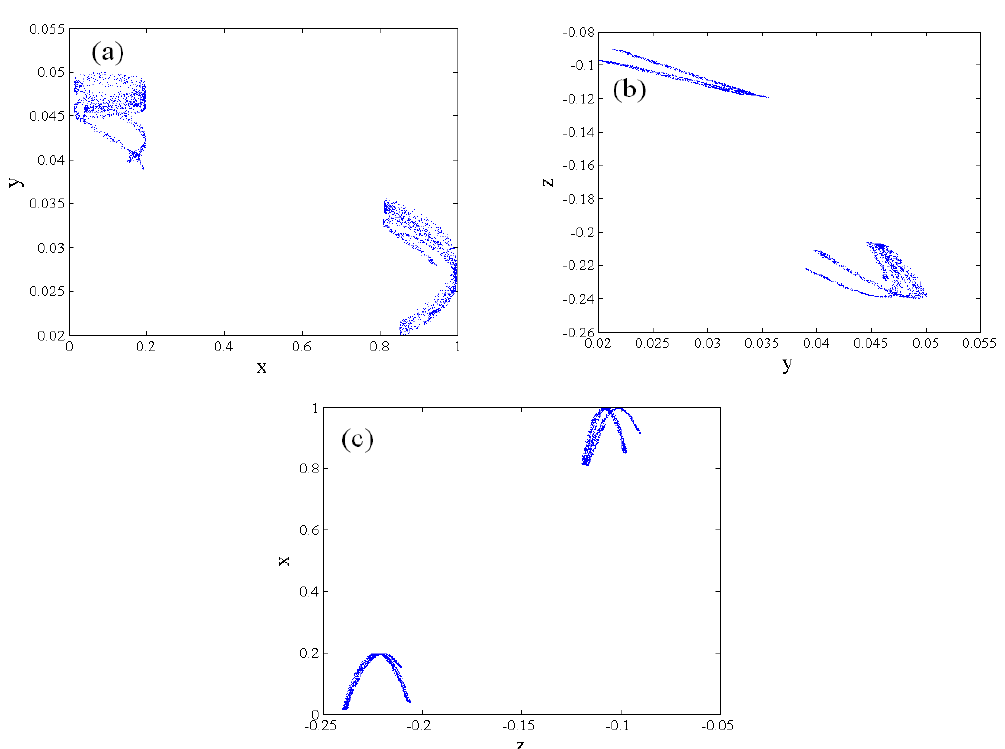
Figure 1. Chaotic attractors of the fractional-order improved quantum logistic map. ( a ) x - y phase portrait; ( b ) y - z phase portrait; ( c ) z - x phase portrait.